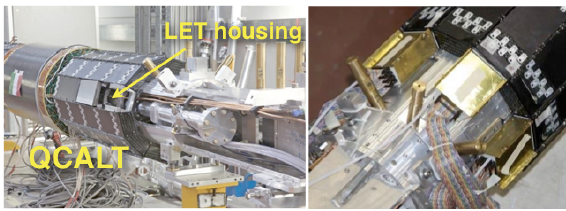
Figure 5. Left : QCALT dodecagonal structure with the LET housing in evidence. Right : QCALT structure with front-end cables in evidence.